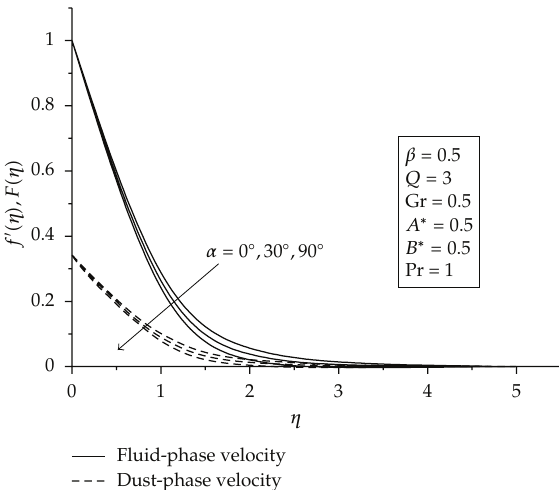
Figure 4: Velocity profile for di ff erent values of angle of inclination.